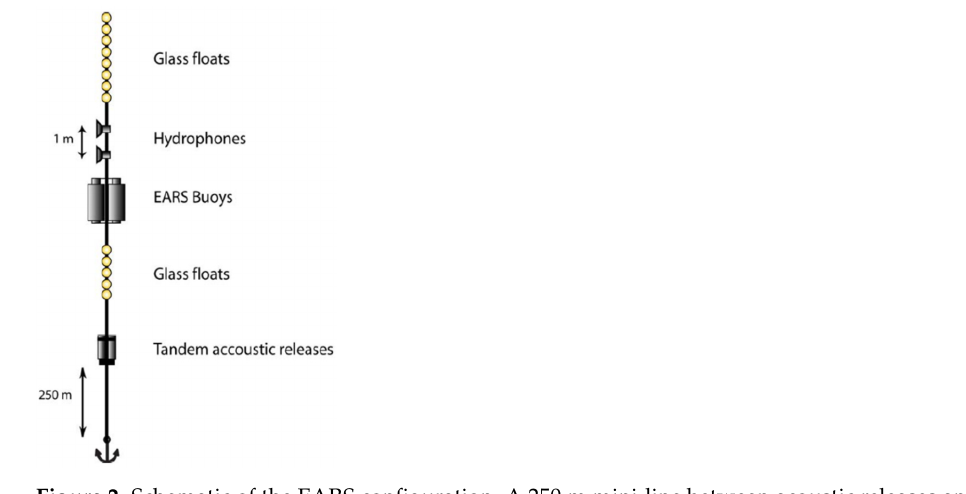
Figure 2. Schematic of the EARS configuration. A 250 m mini-line between acoustic releases and the anchor was used for the shallower Western site and a 500 m mini-line was used for the Northern and Southern sites to target hydrophone placement depths close to the foraging depths of sperm and beaked whales.